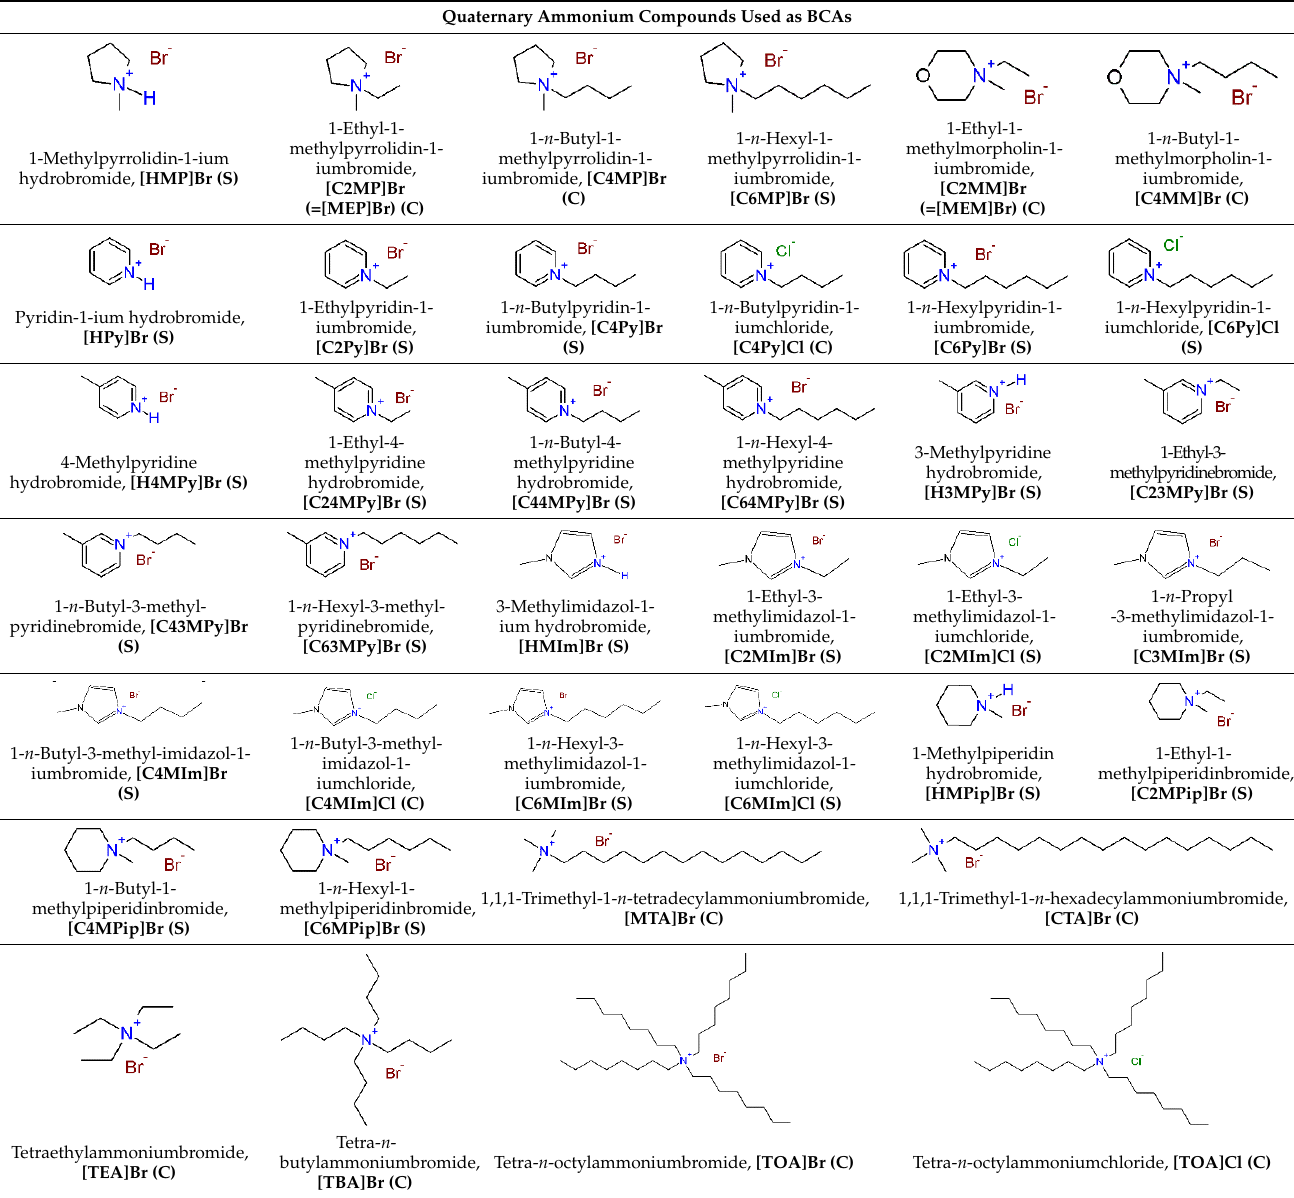
Table 1. Quaternary ammonium halides for investigation of their properties as bromine complexing agents represented by their structure, name and abbreviation (bold). Letters in brackets identify substances that are synthesized at Fraunhofer ICT (S) and are used from commercial suppliers (C) . Details are mentioned in the Supplementary Materials (SM). Quaternary Ammonium Compounds used as BCAs